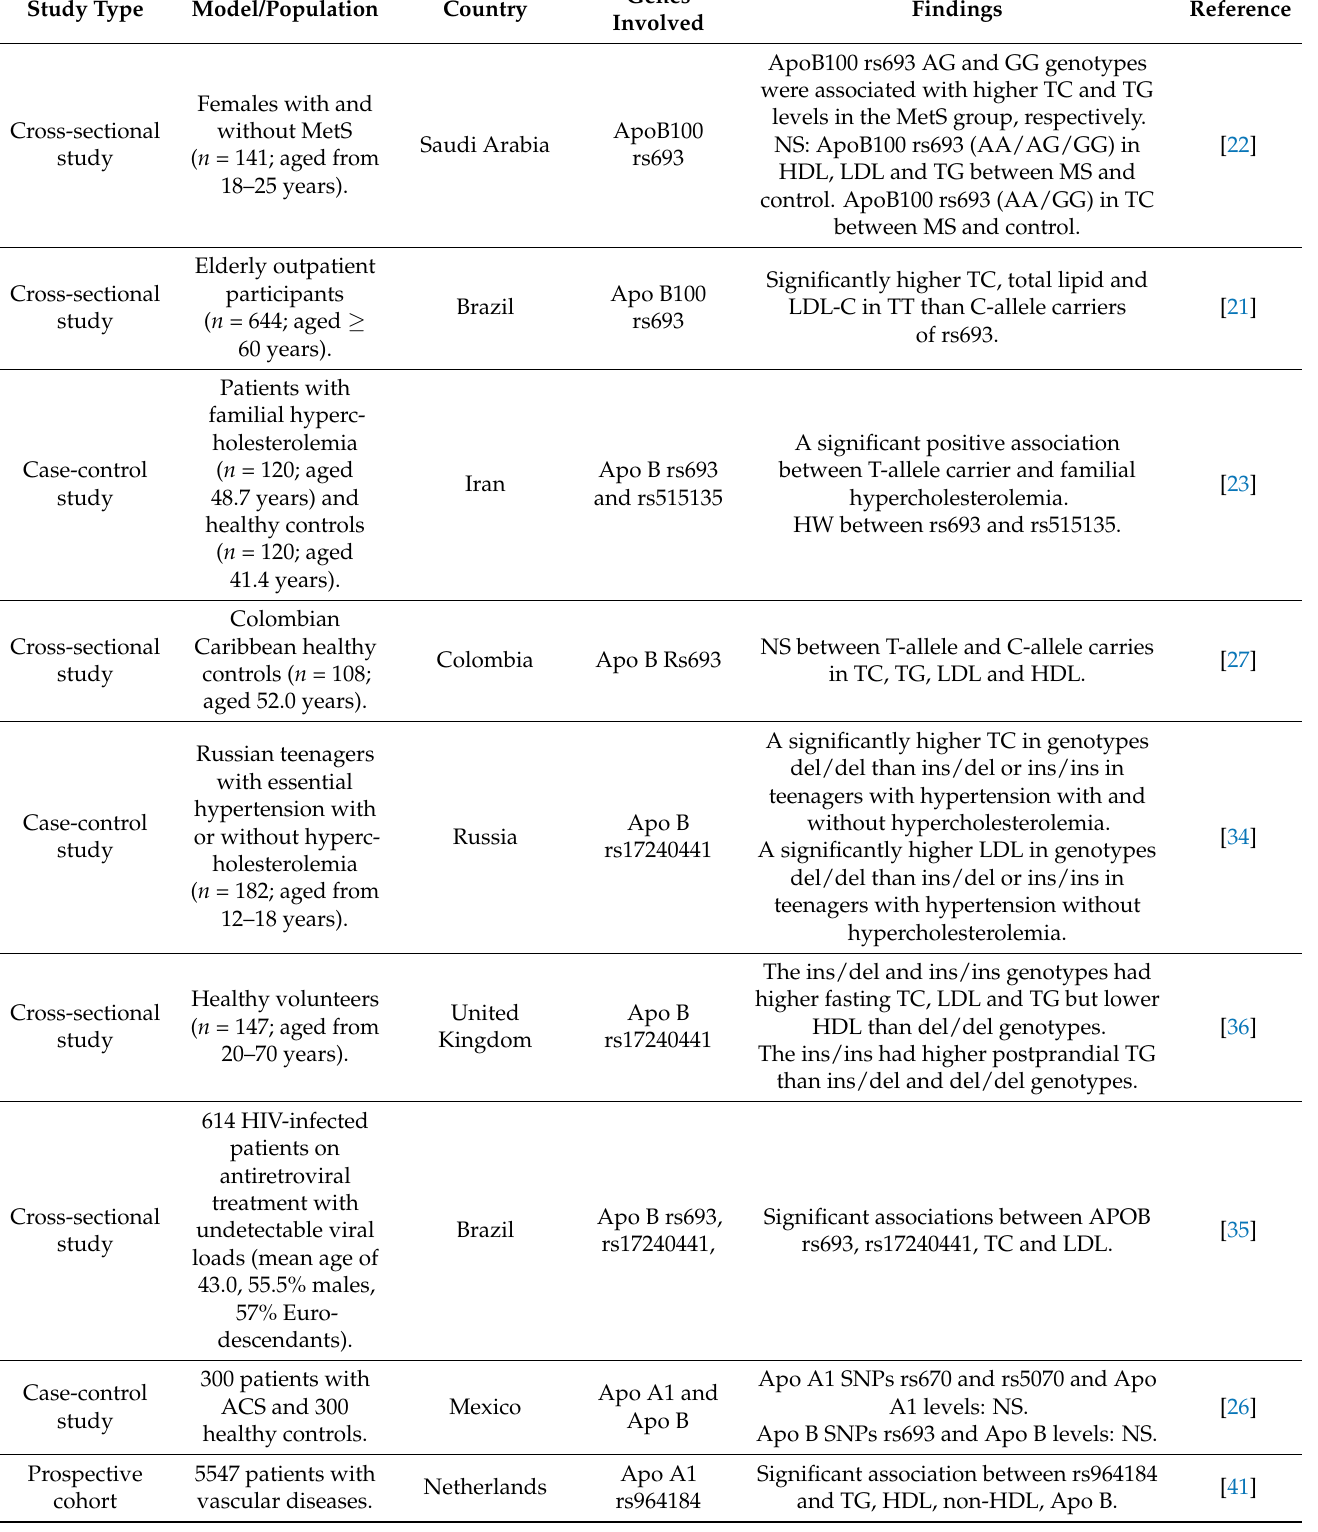
Table 1. The relationship between specific polymorphisms of apoliprotein and lipid